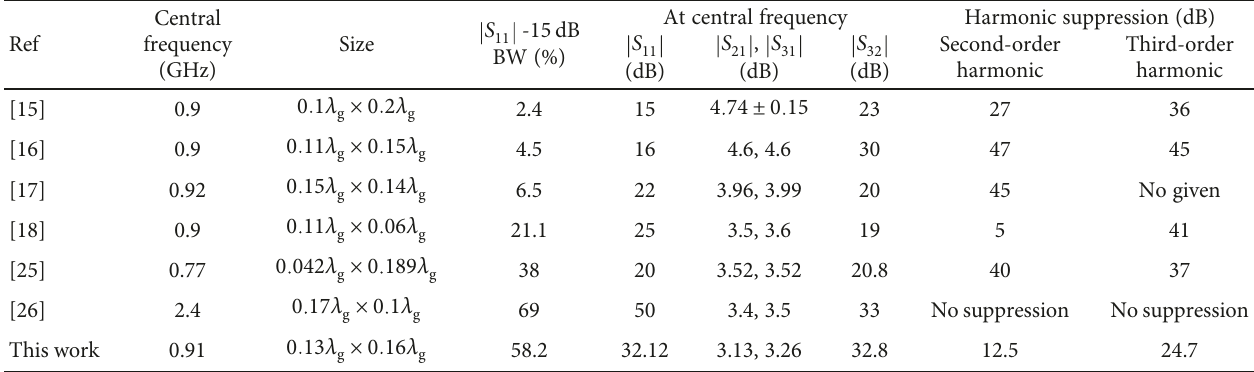
Figure 12: Comparison of simulated S -parameters between the proposed and conventional Wilkinson power divider. Table 3: Performance comparisons of power